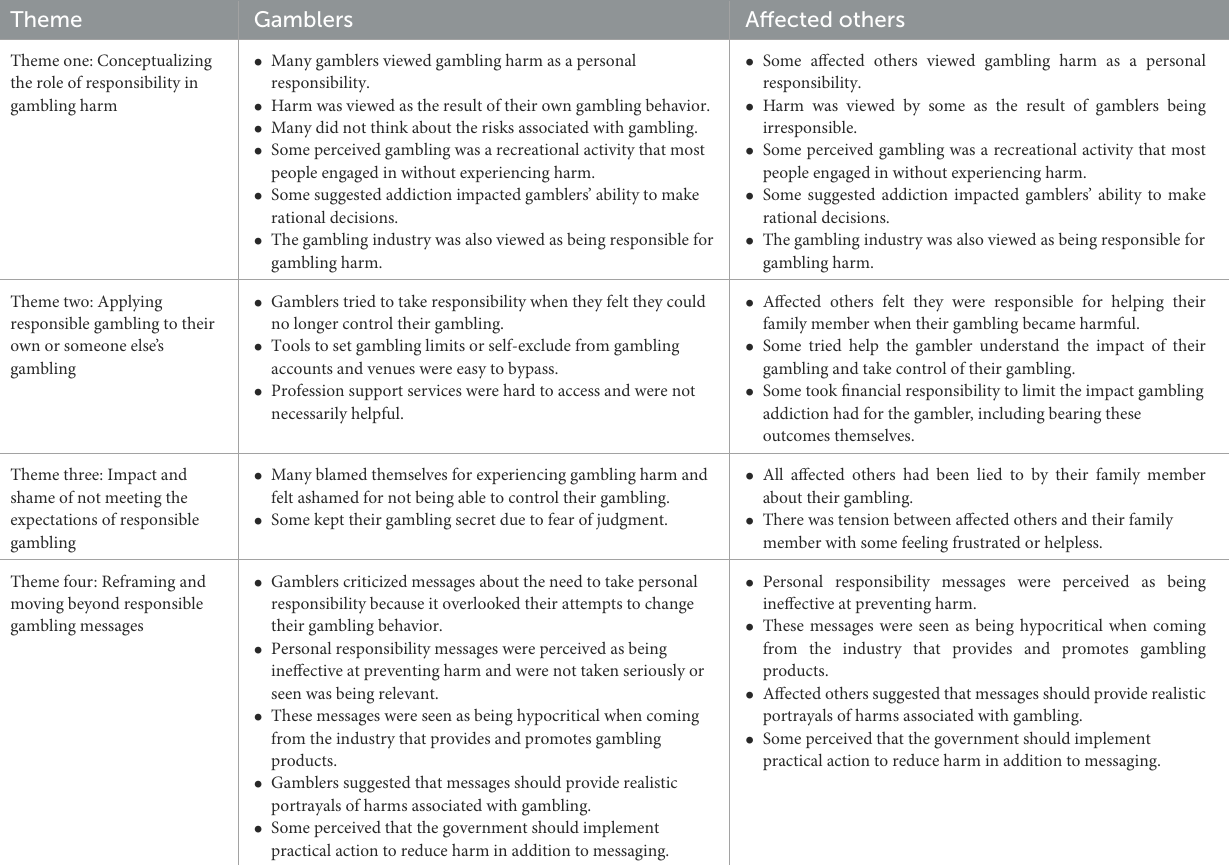
TABLE 2 Summary of the themes according to responses by gamblers and affected